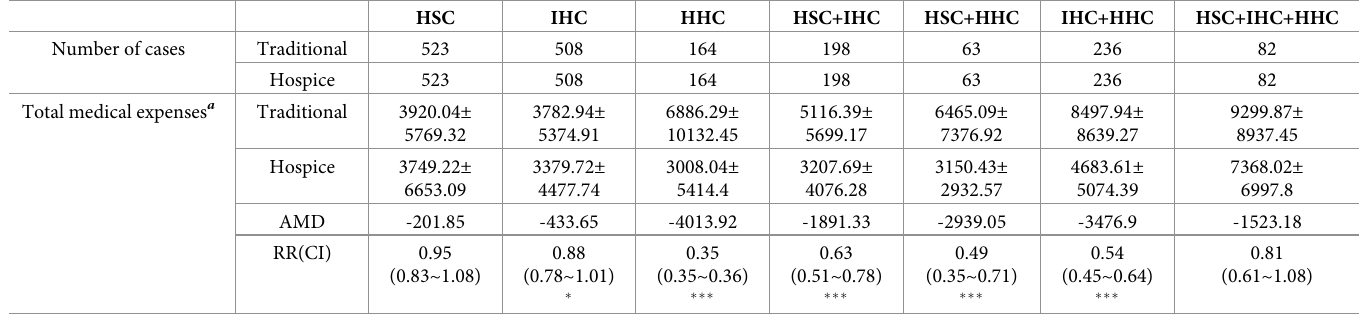
Table 5. Differences in medical expenses between traditional care and various hospice care patients a .